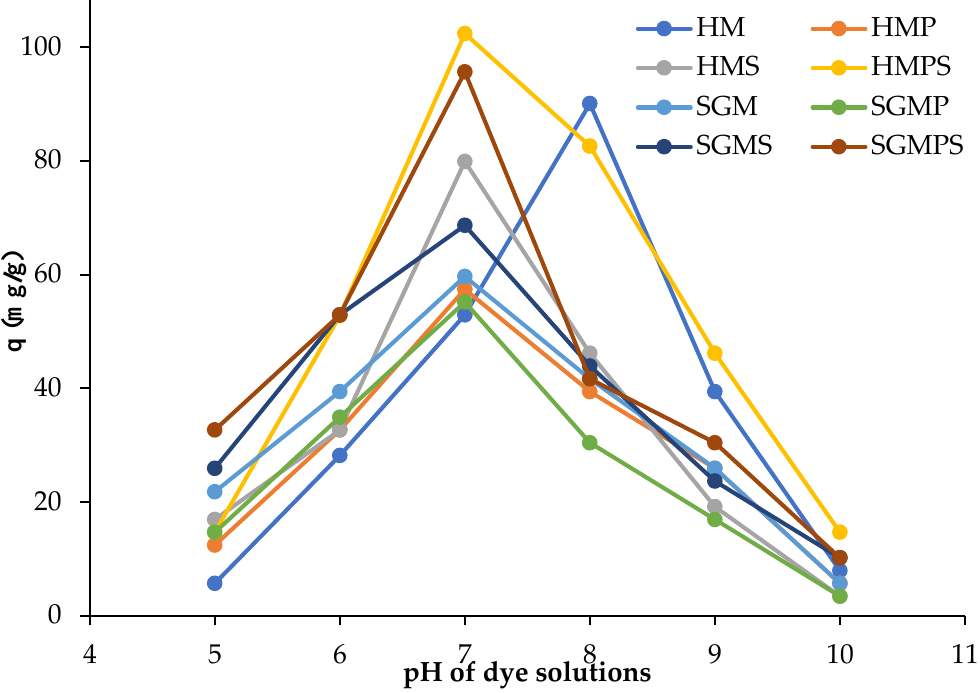
Figure 4. Effect of pH on direct violet 51 adsorption by various materials.